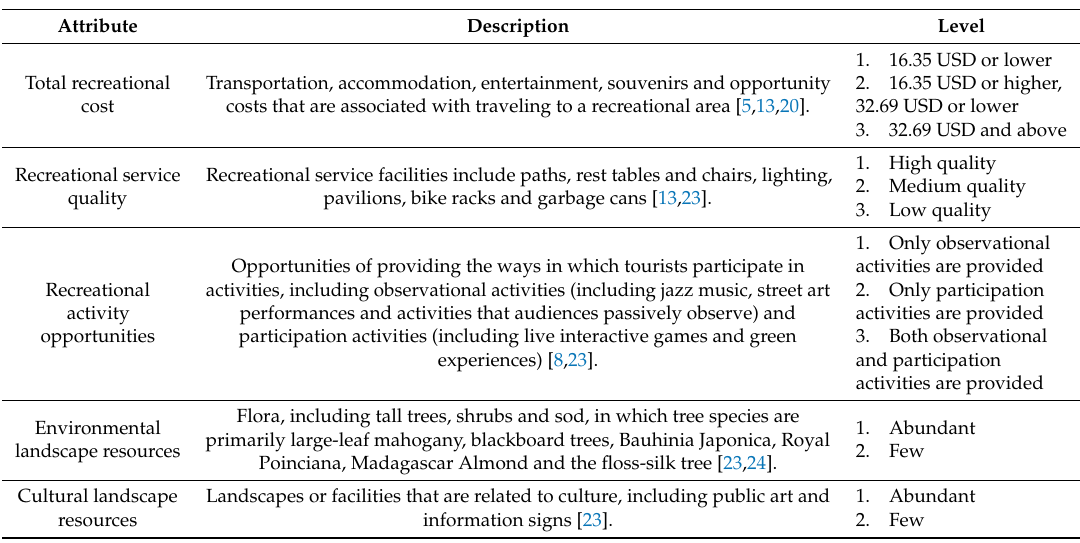
Table 1. The attributes that influence the preferences on selecting recreational areas and their levels. Attribute Description Level Total recreational cost